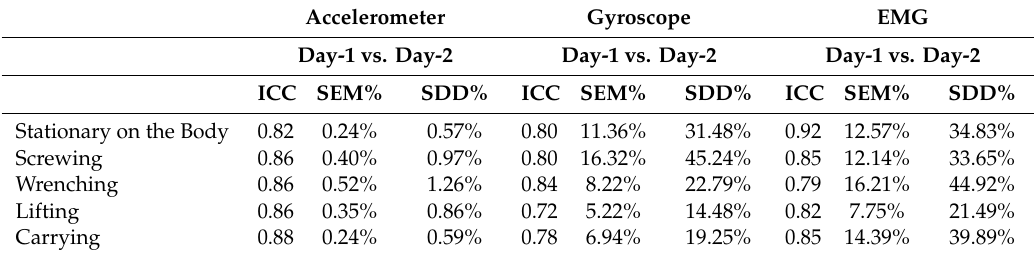
Table 8. Accelerometer, gyroscope, and EMG day-to-day reliability assessment.